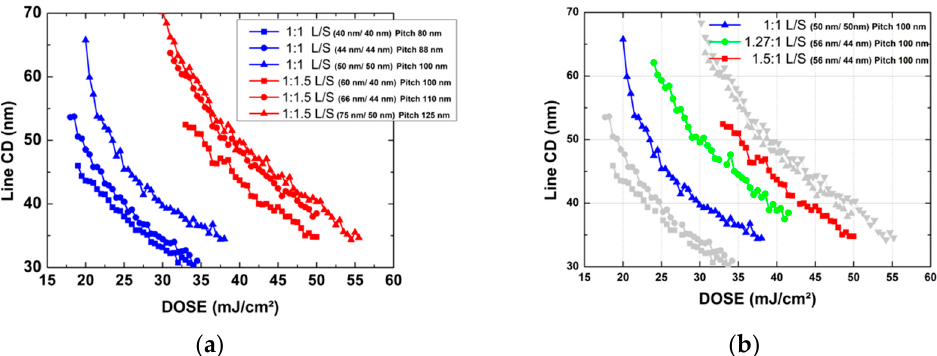
Figure 4. Line CD dependence on DOSE ( a ) according to Mask open ratio and ( b ) according to L/S ratio applicable to +A and +2A sections at the same pitch (line 50 nm).